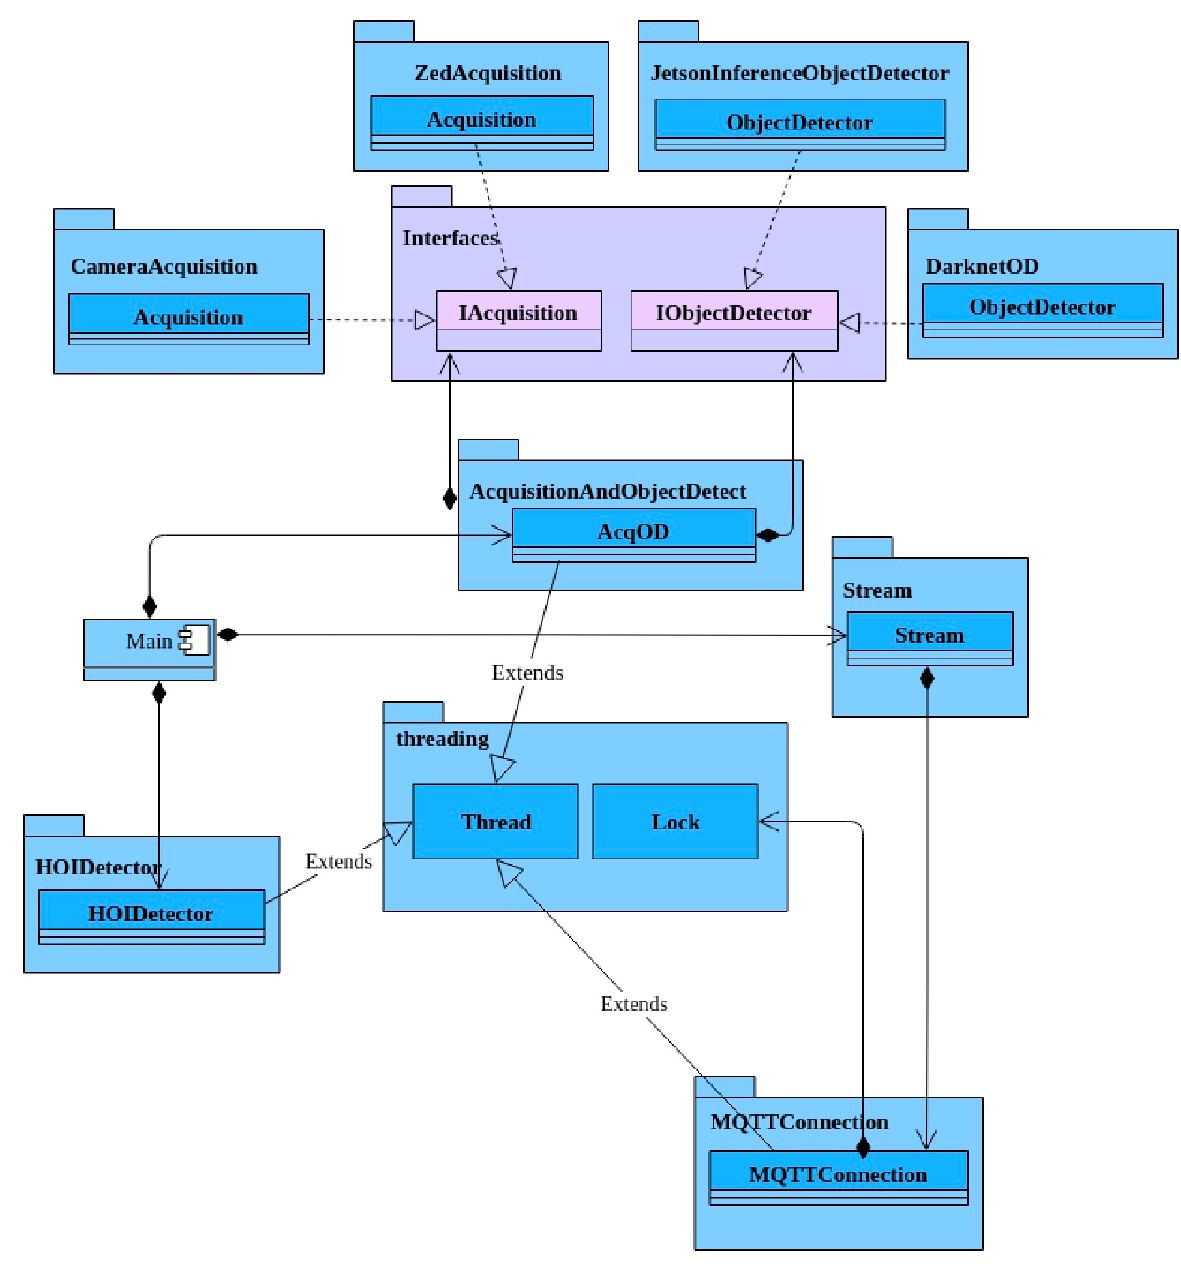
Figure 9. Class diagram.